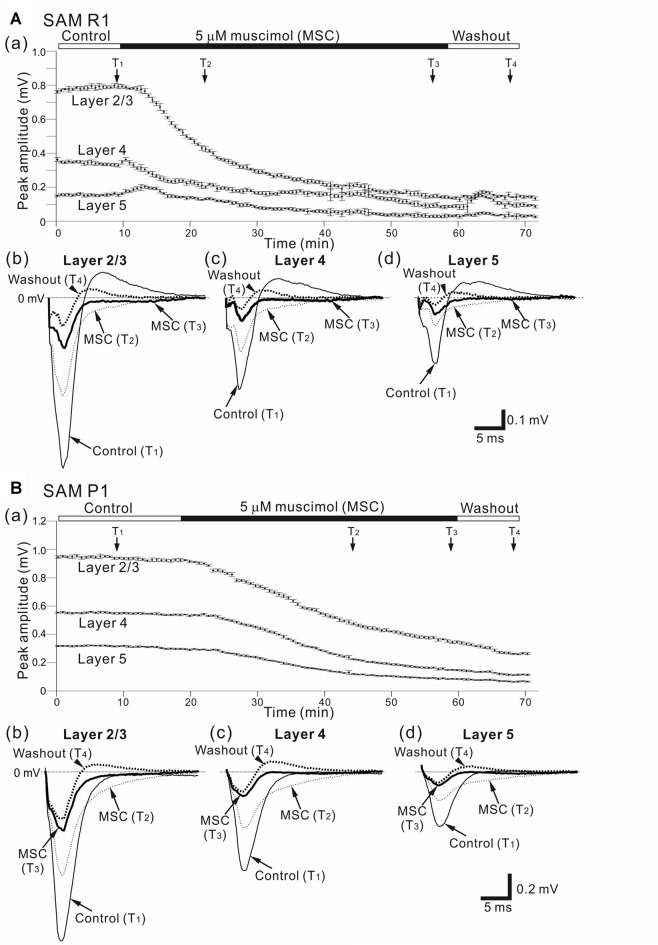
Effects of muscimol (MSC) on cortical LFP responses evoked by stimulation at one site in L4. (A) A representative example of an older SAMR1 mouse (12.5-month old). In (a), superfusion of 5-μM MSC decreased the negative peak amplitudes of LFPs (T2 and T3) in the three layers (L2/3, L4 and L5), compared with control (T1). At T4, the drug had been washed out. Durations of the three (control, 5-μM MSC, and washout) conditions are given in the black and white bars on the top. Typical LFP responses in L2/3 (b), L4 (c) and L5 (d) at the four time points (T1, T2, T3 and T4) are illustrated. (B) Similarly, a representative example of an older SAMP1 mouse (13-month old). In (a), superfusion of 5-μM MSC also decreased the negative peak amplitudes of LFPs (T2 and T3), compared with control (T1). At T4, the drug had been washed out. Typical LFP responses in L2/3 (b), L4 (c) and L5 (d) at the four time points (T1, T2, T3 and T4) are illustrated.